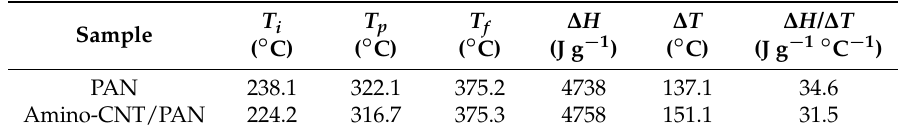
Figure 6. DSC curves of ( a ) PAN homopolymer and ( b ) amino-CNT/PAN microspheres in air atmosphere. Table 3. DSC data for PAN homopolymer and amino-CNT/PAN microspheres in air atmosphere.